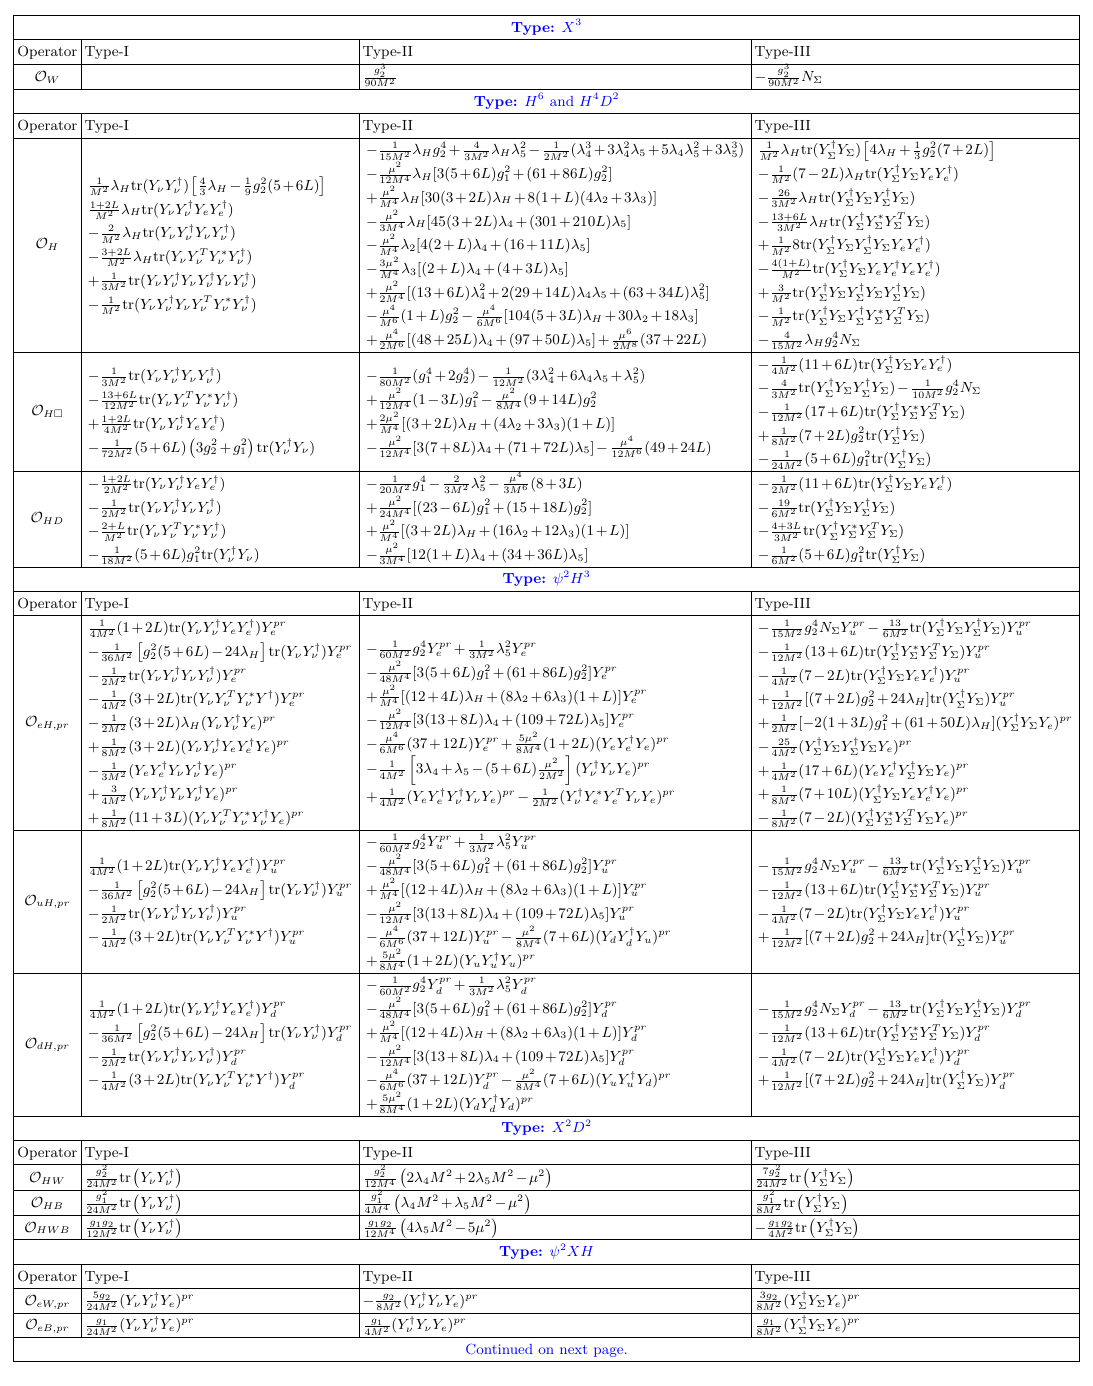
Table 8 . Higher dimensional operators in the Warsaw basis from one-loop matching. Once again, we classify the operators by their types as specified in blue, and the specific forms of these operators are listed in table